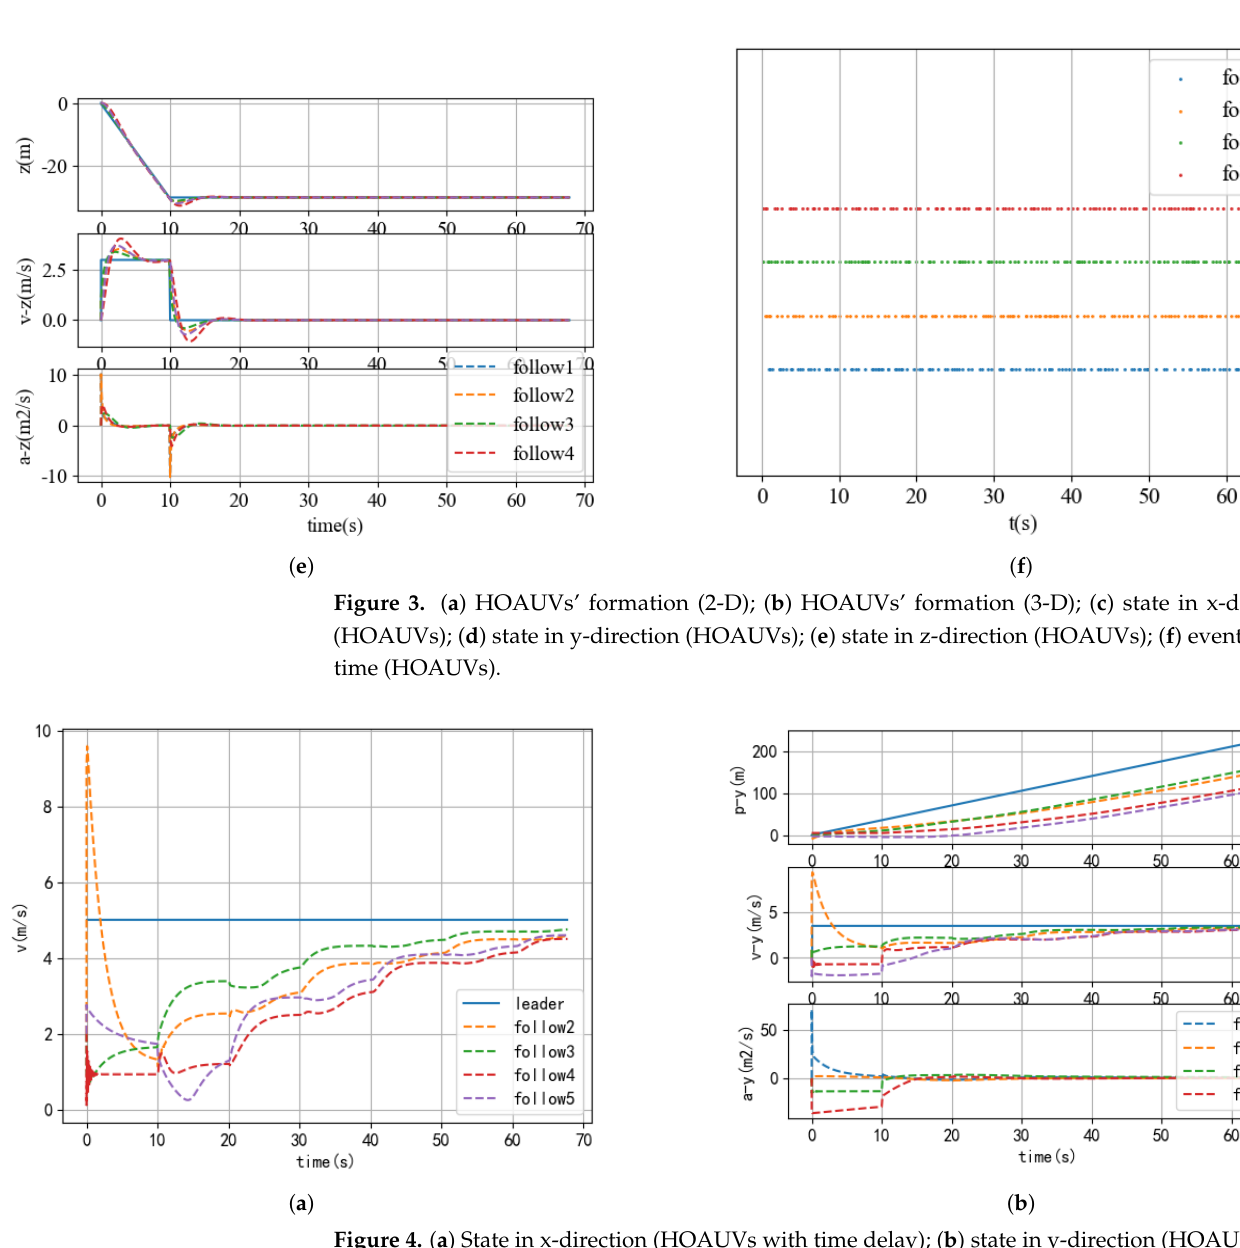
Figure 4. ( a ) State in x-direction (HOAUVs with time delay); ( b ) state in y-direction (HOAUVs with time